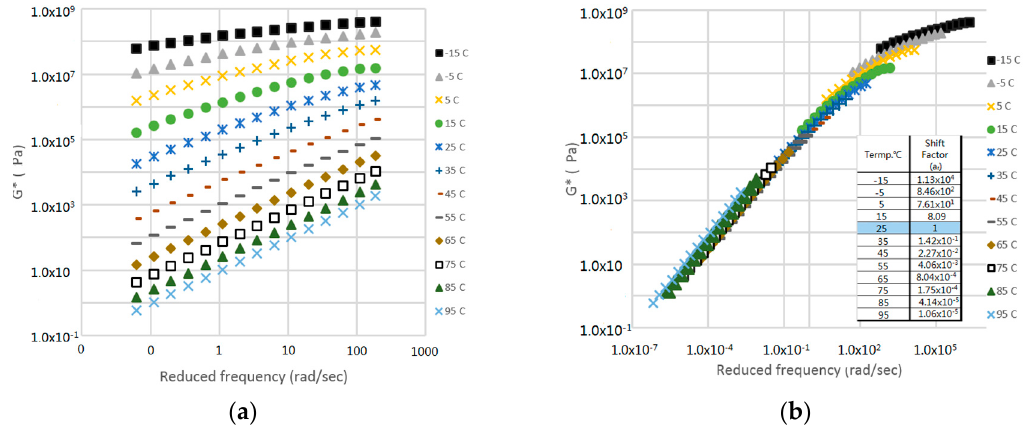
Table 8. Activation energy E a of binders.